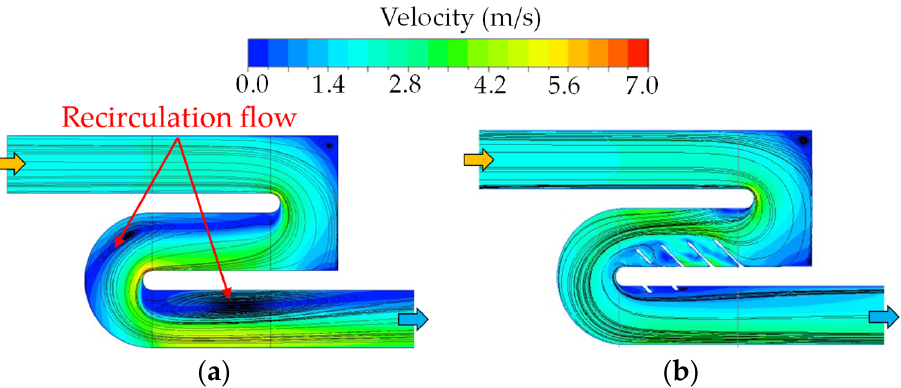
Figure 20. Velocity distributions and streamlines in the middle section of the serpentine channel: ( a ) baseline model; ( b ) TO model with diamond-TPMS structure.